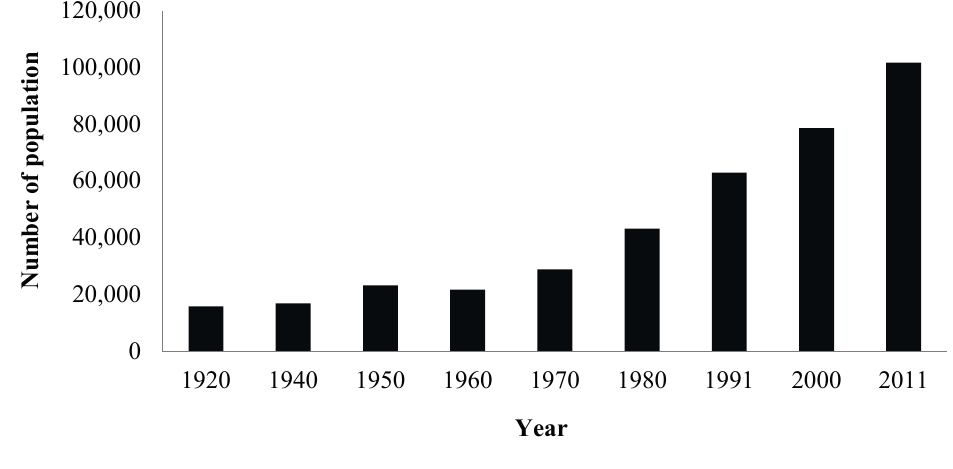
Figure 1. Population growth in the county of Formosa from 1920–2011 [6–7].